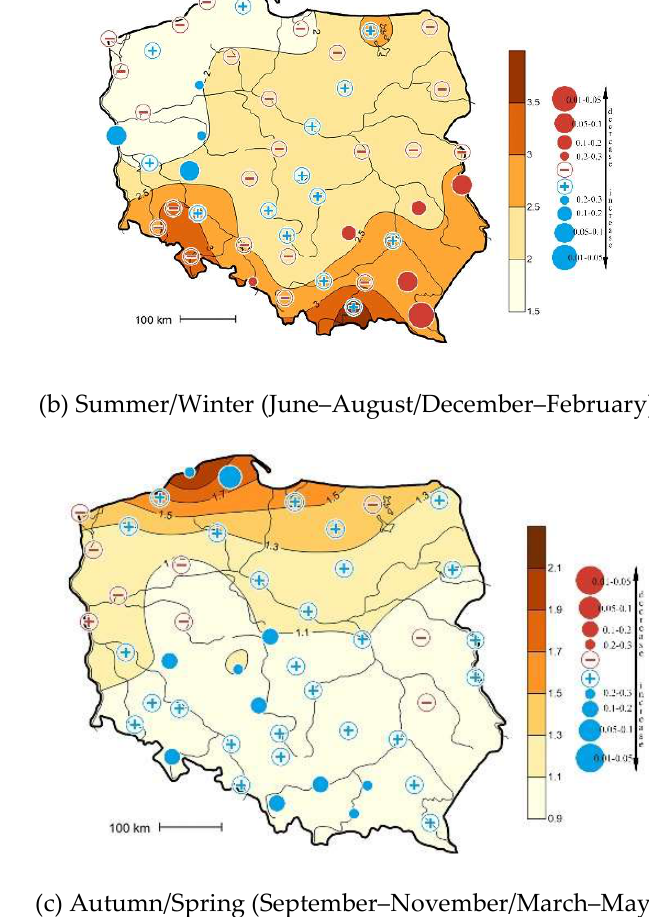
Figure 6. Ratios of precipitation totals in 2001–2018: (a) warm and cold half–year (April–September/October–March), (b) summer and winter (June–August/December–February), and (c) autumn and spring (September–November/March–May); and the level of significance of changes in the ratio of precipitation totals in 2001–2018 based on the Mann–Kendall test.